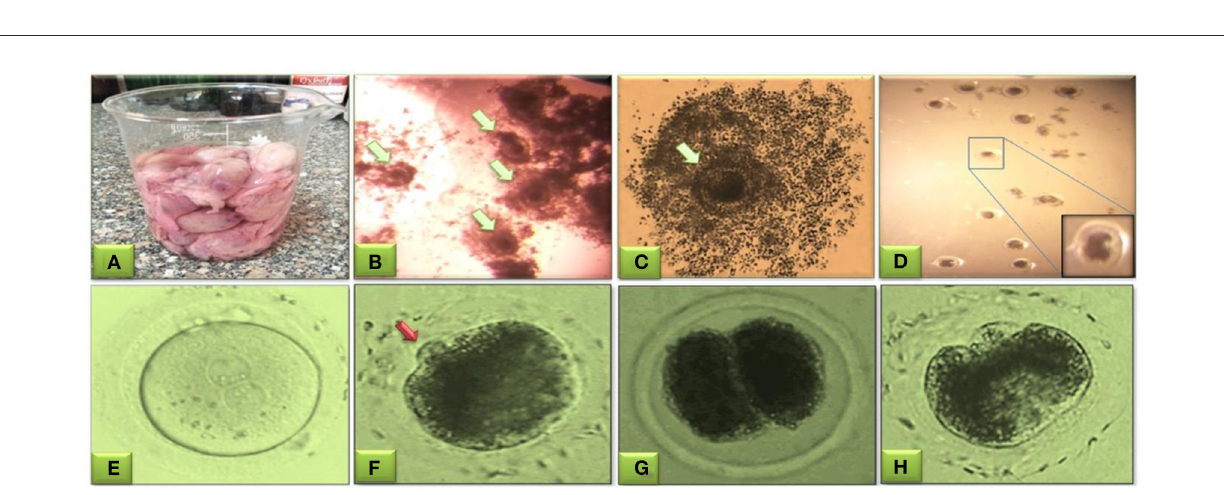
FIGURE2 Buffalo oocytes obtained from slaughterhouse ovaries for aspiration of immature cumulus oocytes’ complexes (COCs) from follicles of 3–8mm size (A) . Microscopic selection of the good quality even-shaped nucleated oocytes surrounded by expanded cumulus cells ( B, C , green arrow). Mature oocytes after washing three times in IVF-TALP medium (D) . Evaluation of fertilization and cleavage stages in buffalo embryos; fertilized oocyte presenting the male and female pronuclei (E) , fertilized oocytes with polar body (red arrow) (F) , start of cleavage showing the two-cell stage cleaved embryo (G) , and the four-cell stage cleaved embryo (H) . This figure is partially retrieved from another recent piolet study (27) based on previous studies (22,